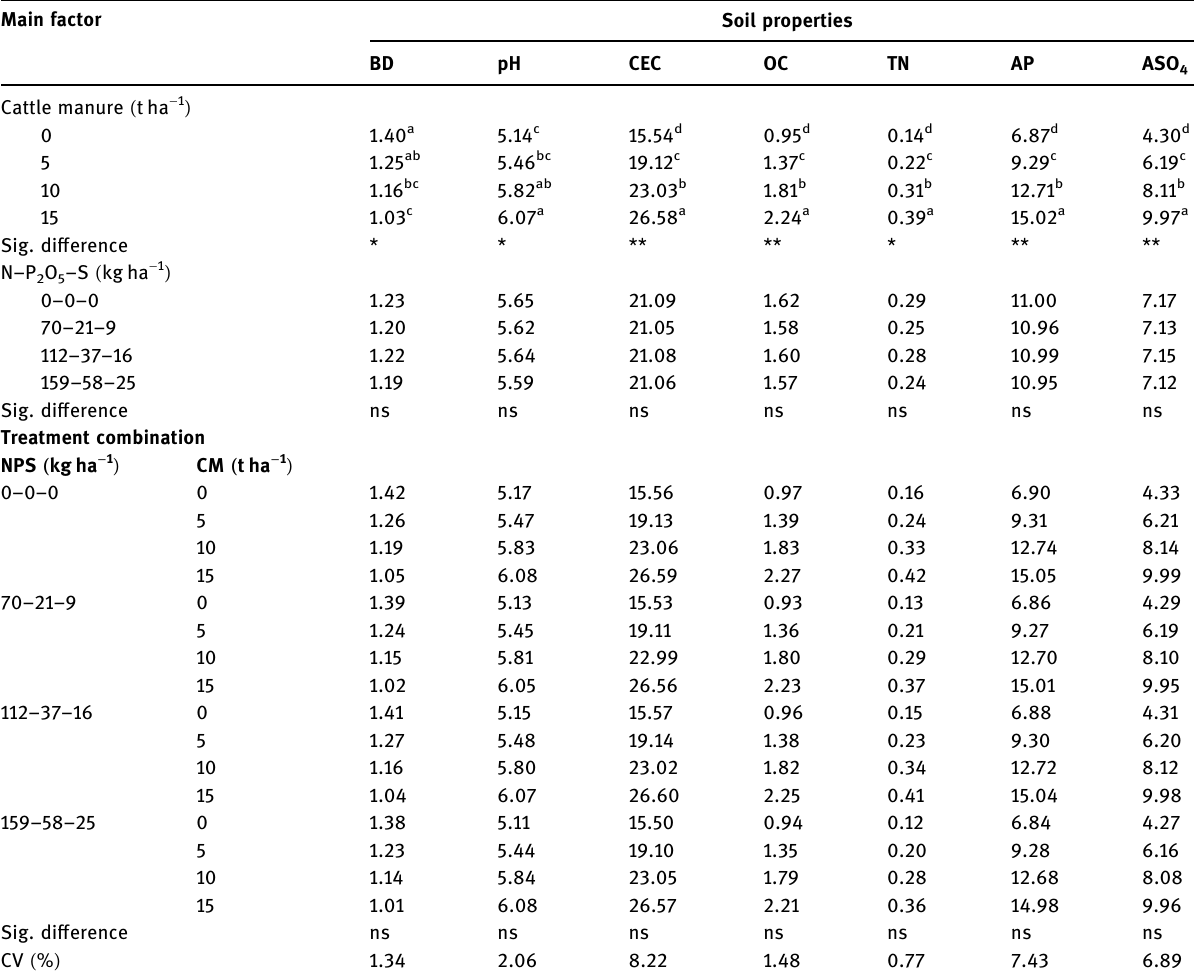
Table 3: Main and interaction e ff ects of NPS inorganic fertilizers and cattle manure application on physicochemical properties of the experimental